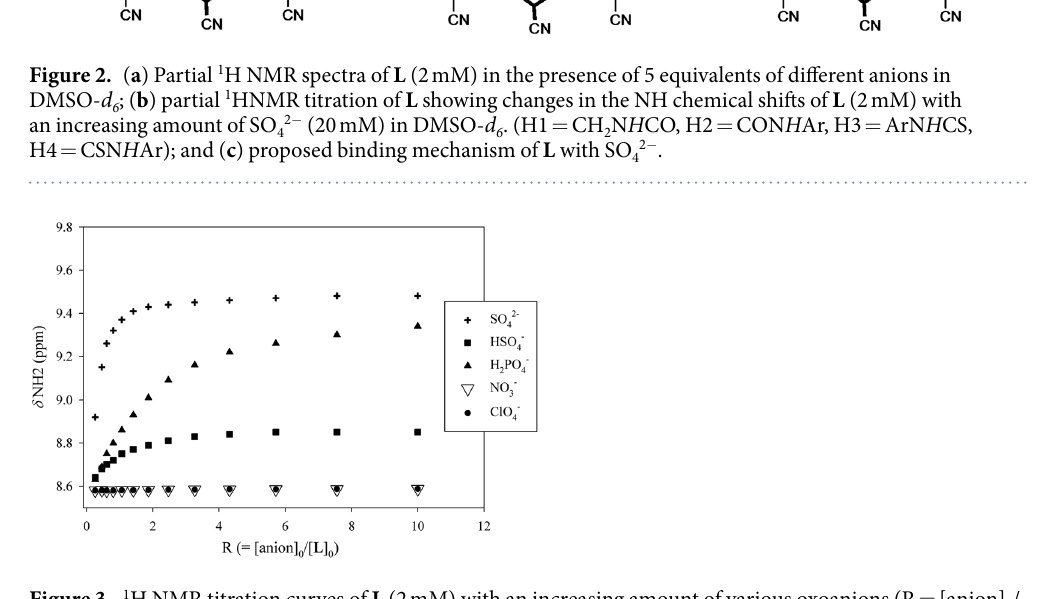
showing Δ NH1 = 0.37, Δ NH2 = 0.28, Δ NH3 = 0.06 and Δ NH4 = 0.09 ppm. The larger shift change ( Δ NH) in the respective NH signal due to the addition of SO 42 − than that of HSO 4 − indicates stronger interactions of SO 42 − as it contains two charges. The addition of H 2 PO 4 − to L resulted in downfield shifts of NH1 and NH2 signals, while both NH3 and NH4 signals were broadened as observed previously for related ligands 43, 44 . In contrast, the addition of ClO 4 − or NO 3 − to L did not show any noticeable change in the shifts of NH or aromatic protons (see the Supporting Information, Figs S12 and S13), thus indicating weaker interactions between the perchlorate or nitrate anions and the receptor. Figure 2b shows the stacking of 1 H NMR spectra of L with varying amount of SO 42 − (0 to 10 eq.) in DMSO- d 6 , exhibiting gradual downfield shifts of NH signals. The shift changes for NH resonances (Fig. 3), however, were not consistent with a purely 1:1 binding model as commonly observed for related molecules 33 . Therefore, they were analyzed with a 1:2 ( L :sulfate) binding model using the EQNMR program 46 , displaying the binding constants (in log K ) of 3.06(2) and 2.56(4) for L + SO 42 − = [ L (SO 4 )] 2 − and [ L (SO 4 )] 2 − + SO 42 − = [ L (SO 4 ) 2 ] 4 − , respectively.